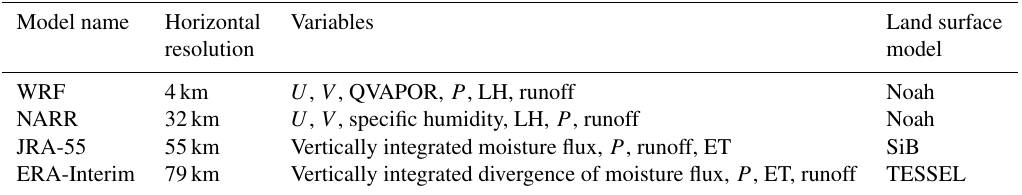
Table 1. Reanalysis products used in the comparison with WRF–CTL. P is precipitation, LH is latent heat, ET is evaporation, and QVAPOR is the vapour mixing ratio. Model name Horizontal Variables Land surface resolution model WRF 4km U , V , QVAPOR, P , LH, runoff Noah NARR 32km U , V , specific humidity, LH, P , runoff Noah JRA-55 55km Vertically integrated moisture flux, P , runoff, ET SiB ERA-Interim 79km Vertically integrated divergence of moisture flux, P , ET, runoff